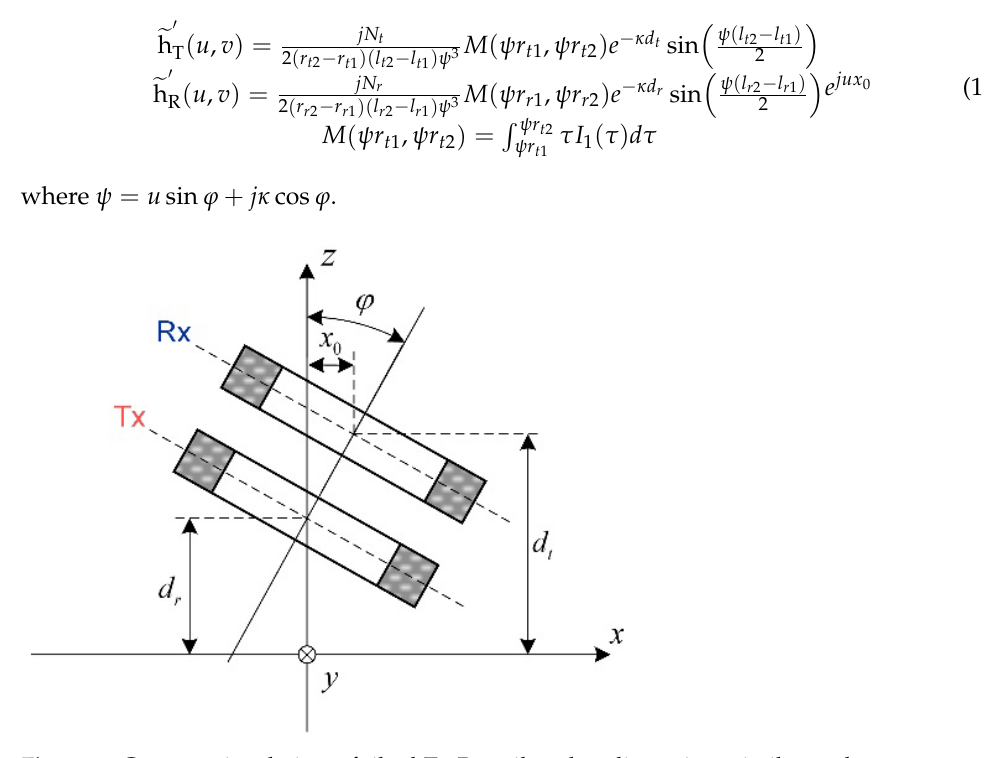
Figure 6. Cross-sectional view of tilted Tx-Rx coils, other dimensions similar as the counterparts without tilt angle.